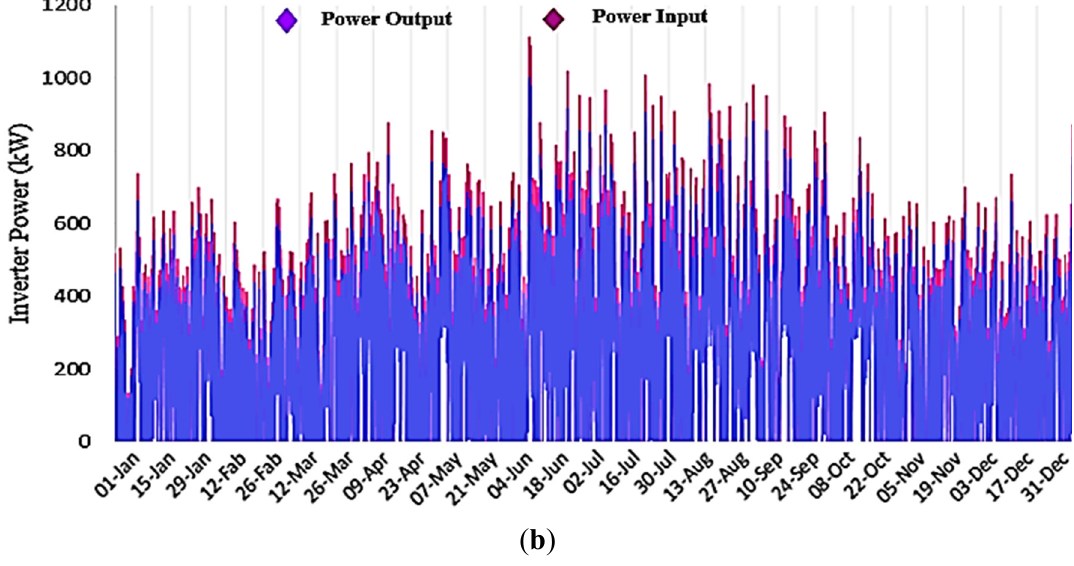
Figure 9. ( a ) The yearly rectifier power input and power output; ( b ) the yearly inverter power input and power